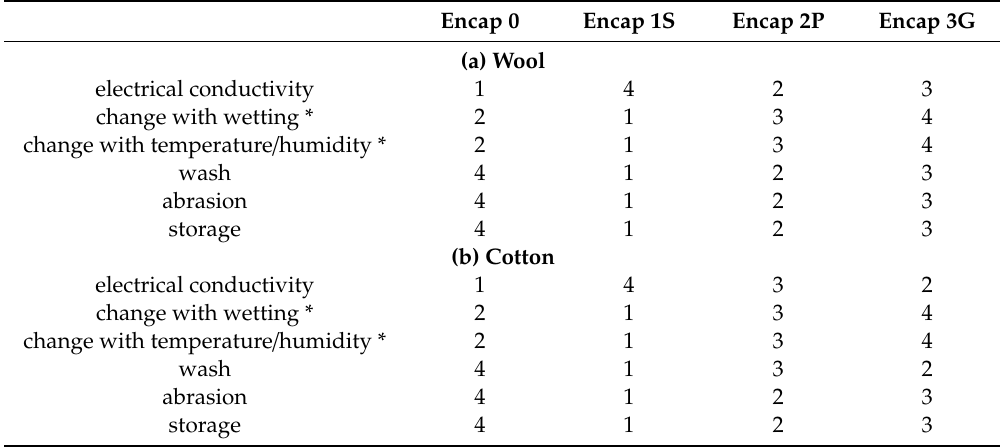
Table 4. E ffi cacy of treatments ranked for e ff ects on electrical Table 4. Efficacy of treatments ranked for effects on electrical conductivity.